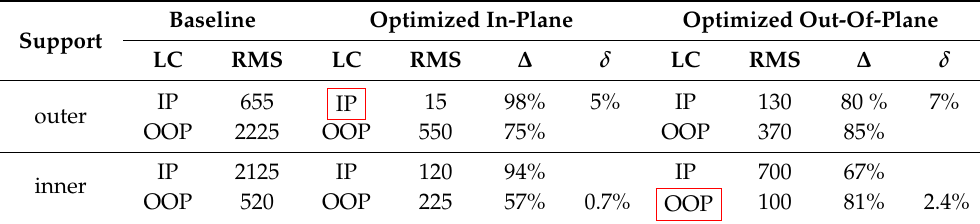
Table 1. Overview of all found optima grouped over load case (LC) and